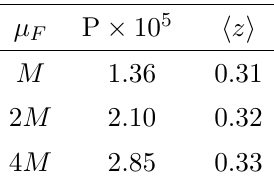
( z, µ F ) with three typical c